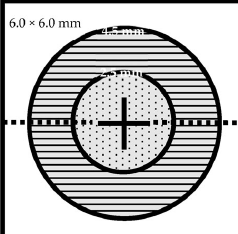
Figure 1. Macular OCT/OCTA cube 6.4 mm × 6.4 mm scan field ( A ) Cube scan analysis parameters: whole image (WI), 6.4 mm × 6.4 mm; superior hemifield (S.Hemi), 3.0 mm × 6.4 mm; and inferior hemifield (I.Hemi), 3.0 mm × 6.4 mm ( B ) ETDRS grid analysis parameters: fovea (ø 0–1 mm), parafovea (ø 1–3 mm), perifovea (ø 3–6 mm), and whole image (6.4 mm × 6.4 mm) ( C ) FAZ area (mm 2 ) (homogenous black area), FAZ perimeter (mm) around FAZ (white line), FD-300 vessel density (%) (patterned ring). Legend: ø, diameter; ETDRS, Early Treatment Diabetic Retinopathy Study; FAZ, foveal avascular zone; FD-300, vessel density in a 300 µm wide ring around the FAZ perimeter.